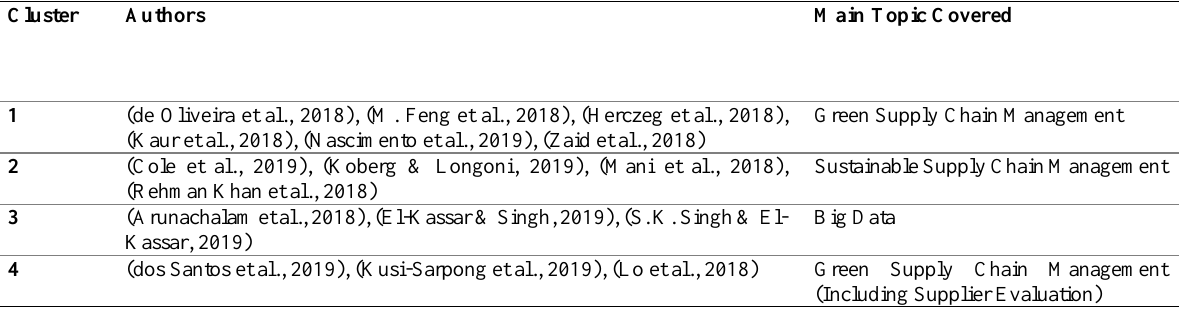
Table 7 : Top Cited Document